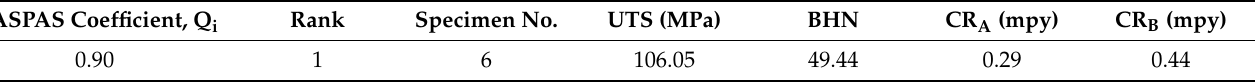
Table 12. Optimized FSW